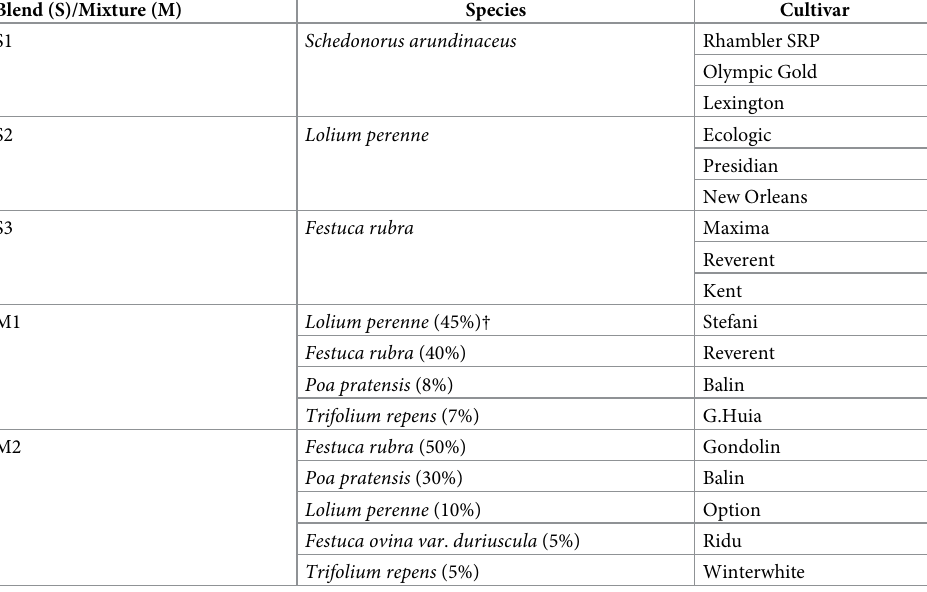
Table 2. Species and cultivars of the three grass blends and two grass-legume mixtures sown in the vineyard inter- rows at Arqu à Petrarca, north-eastern Italy.